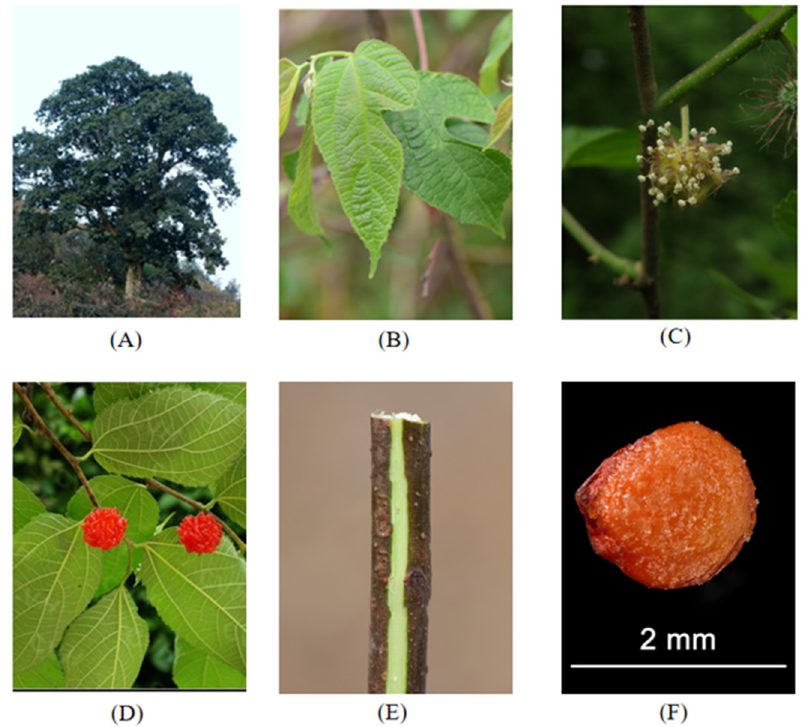
Figure 1. Broussonetia papyrifera (L.) L’Hér. ex Vent. Images A–F show, respectively: the whole plant ( A ), leaves ( B ), flowers ( C ), fruits ( D ), twigs ( E ), and seeds ( F ).